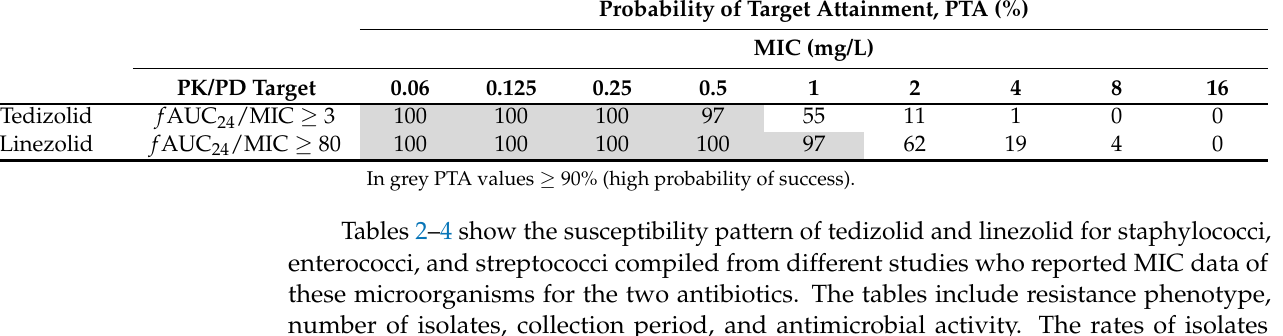
Table 1. Probability of target attainment (PTA) for tedizolid (200 mg q24h) and linezolid (600 mg q12h). Probability of Target Attainment, PTA (%) MIC (mg/L) PK/PD Target